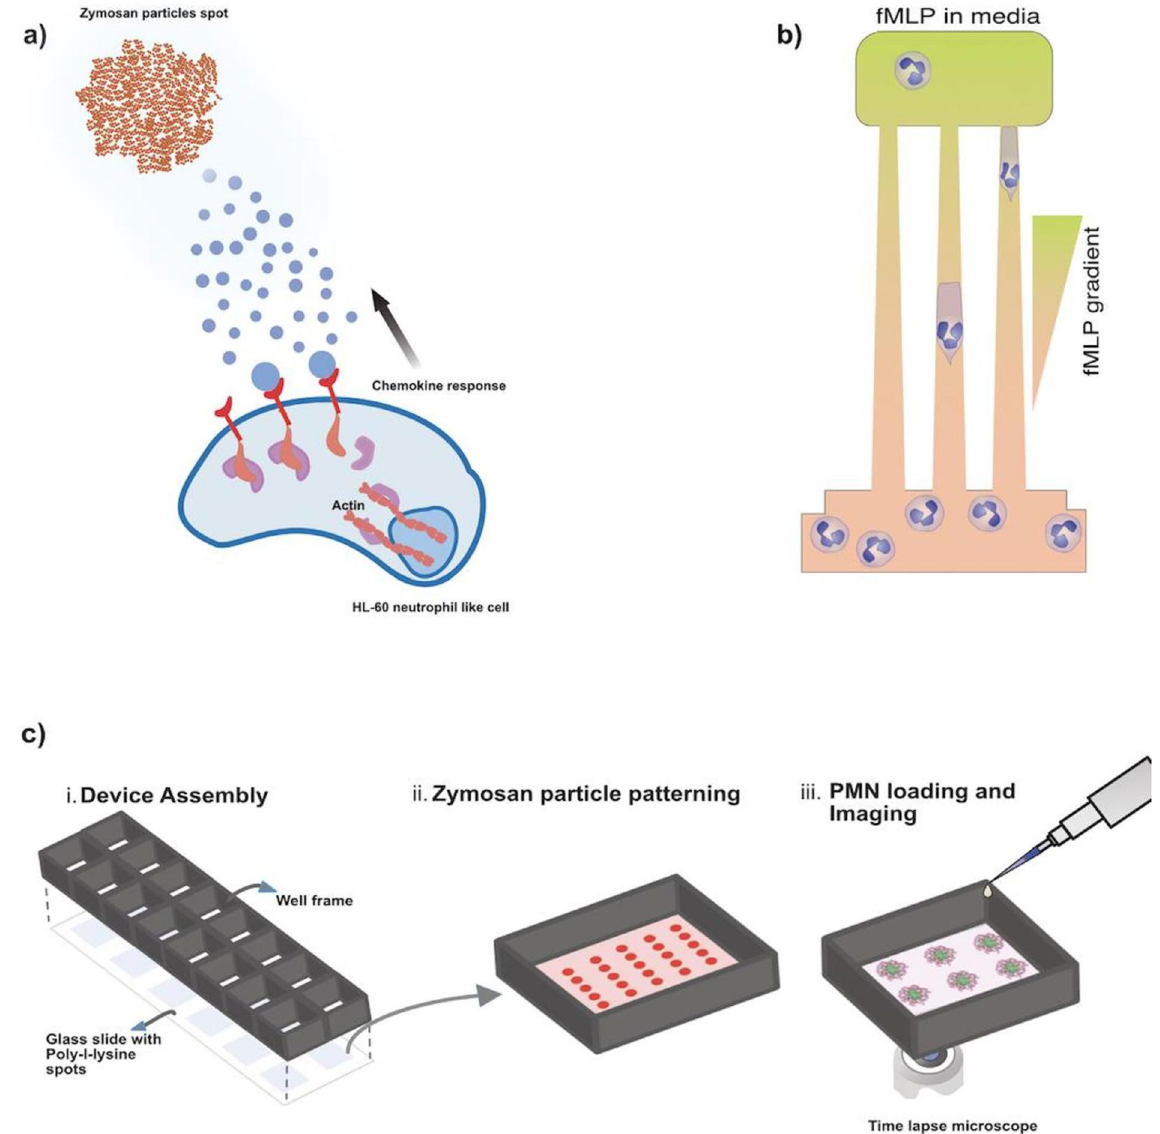
Figure 1. Schematic diagram of tapered channel and swarming assay. ( a ) Schematic image of HL-60 differentiated neutrophil like cells responding to chemokine released by zymosan particles. ( b ) Tapered channel showing neutrophil cells migrating from the cell loading chamber (bottom) to the chambers loaded with chemoattractant fMLP (top). The tapered channel is approximately 500 μm in length and its cross-sectional area decreases from 20 to 6 μm 2 , ( c ) micropatterned zymosan particles (red spots) array for the quantification of HL-60 differentiated neutrophil like cells swarming (i) Schematic illustrations showing the assembly of the 16 well open chamber device, (ii) zoom ‐ in of one of the zymosan particle patterning in the wells. The size of each zymosan spot is 140 µm 2 and each spot is 1 mm apart and (iii) subsequent HL-60 differentiated neutrophil like cells loading and imaging. All images were designed by Affinity Designer Software (version 1.8.4.) https ://affin ity.serif .com/en-us/desig